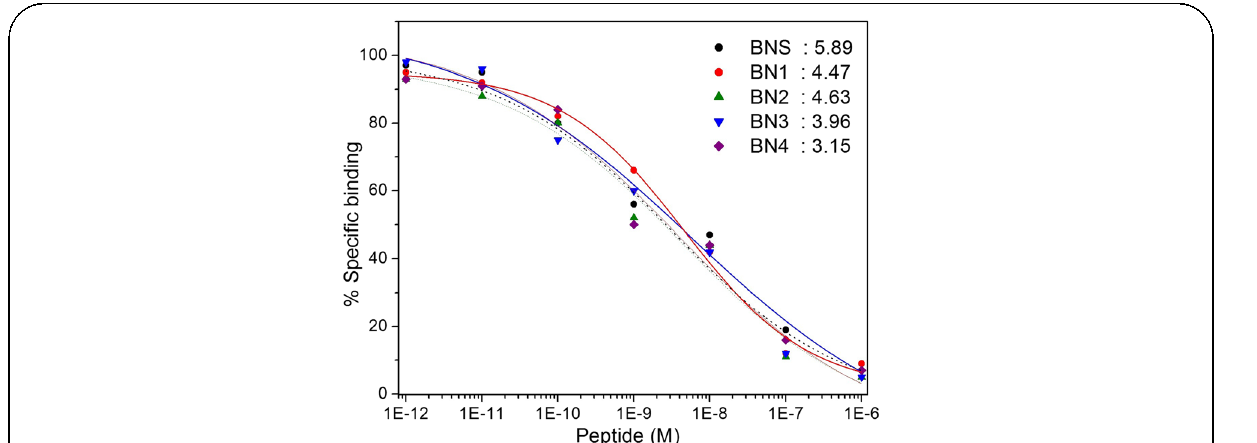
Fig. 4 Receptor binding experiments of using GRP receptor expressing MDA-MB-231 cells. Peptide analogs, along with their IC50 values (in